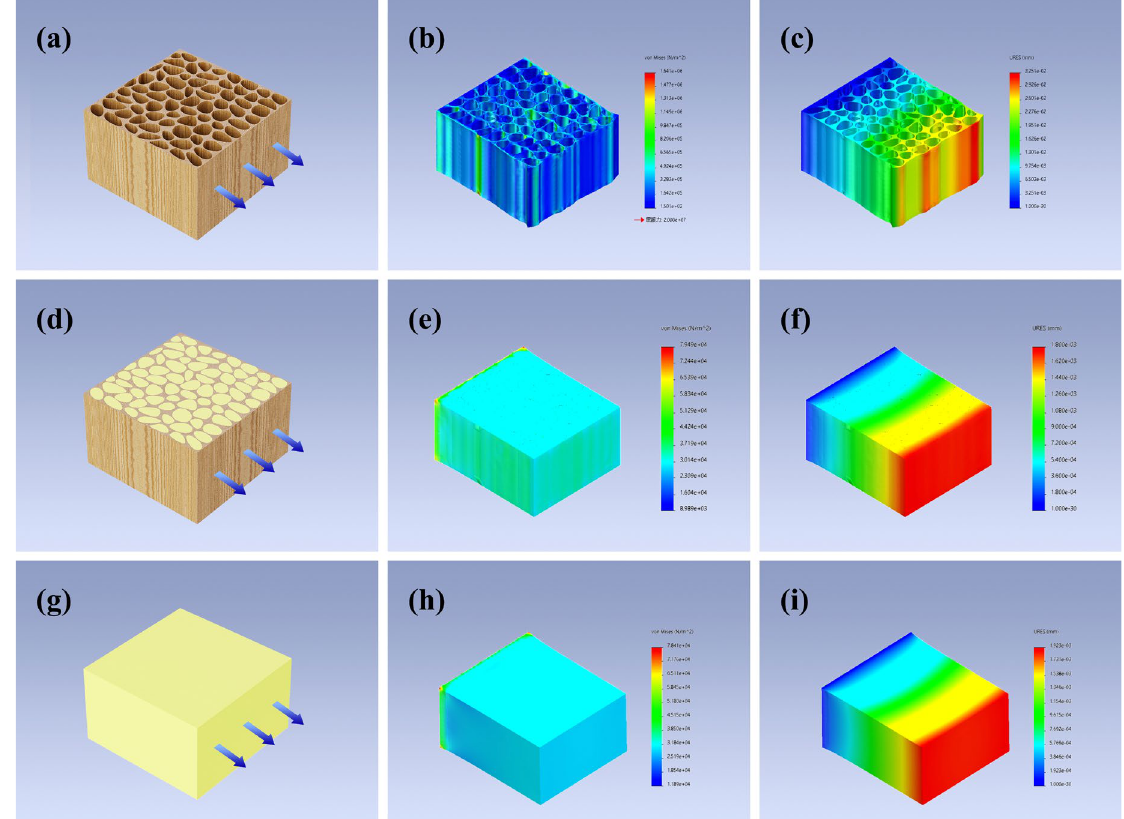
Figure 5. The abstract models of ORW ( a ), FUW ( d ), and epoxy resin ( g ); the stress nephograms of ORW ( b ), FUW ( e ), and epoxy resin ( h ); the displacement nephograms of ORW ( c ), FUW ( f ), and epoxy resin ( i